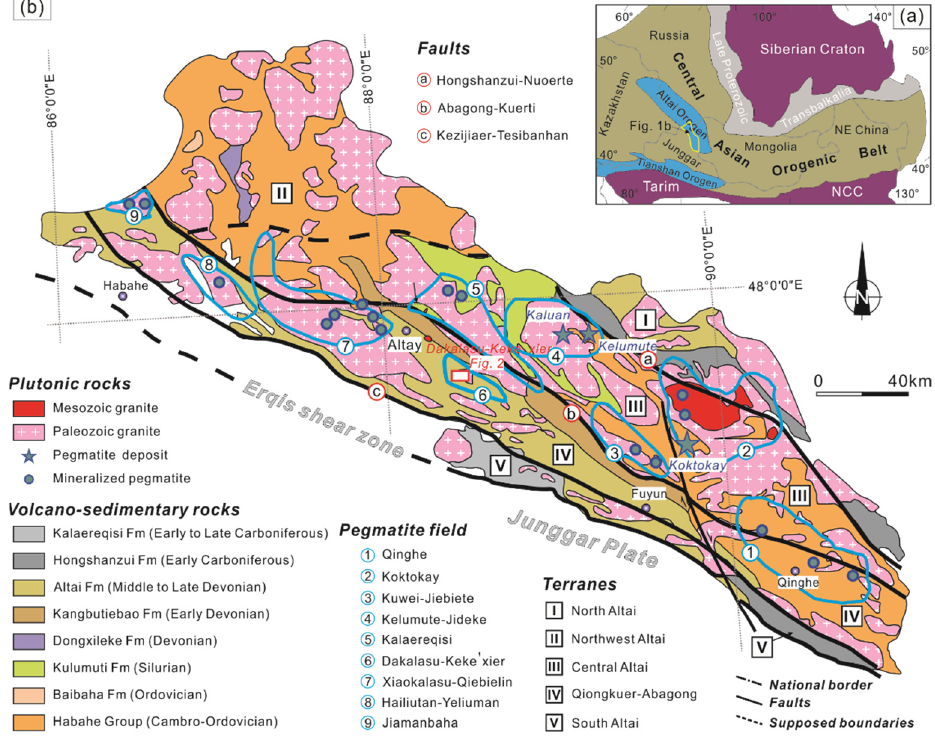
Figure 1. ( a ) Main tectonic units (modified after [23]), of the Chinese Altai orogen and adjacent areas; ( b ) Geological map of the Chinese Altai, showing the location of mineralized pegmatites and deposits (modified from [24]).